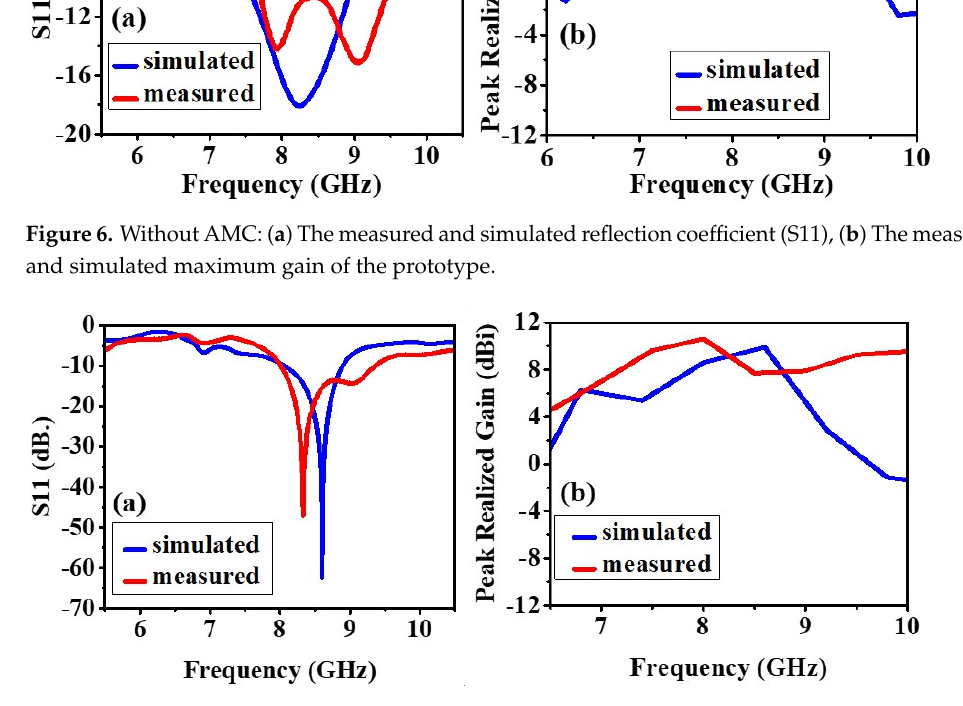
Figure 7. With AMC: ( a ) The measured and simulated reflection coefficient (S11), ( b ) The meas- ured and simulated maximum gain of the prototype.